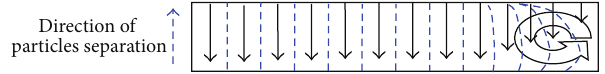
Figure 9: Mechanism of the defect in the cast macrostructure: black arrows, electromagnetic force, white arrow, flow of liquid metal, and dotted lines, trajectories of particles.